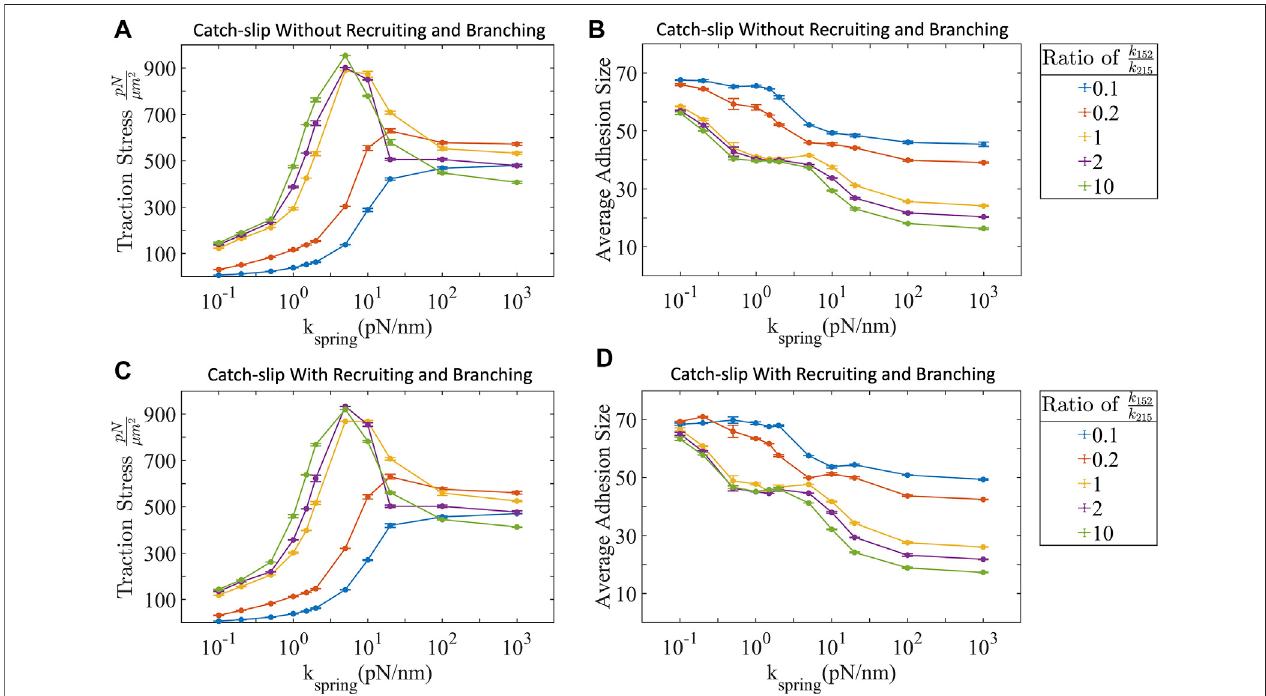
FIGURE 4 | (A) Traction stress without and (C) with talin-mediated adhesion reinforcement demonstrate similar pro fi les. Both conditions show biphasic trends at high ppMLC2:MLC2 and high substrate stiffness. (B) Adhesion size without and (D) with talin-mediated reinforcement decrease with increased ppMLC2:MLC2 and substrate stiffness. Error bars represent ±SEM for 100 fi laments over three independent